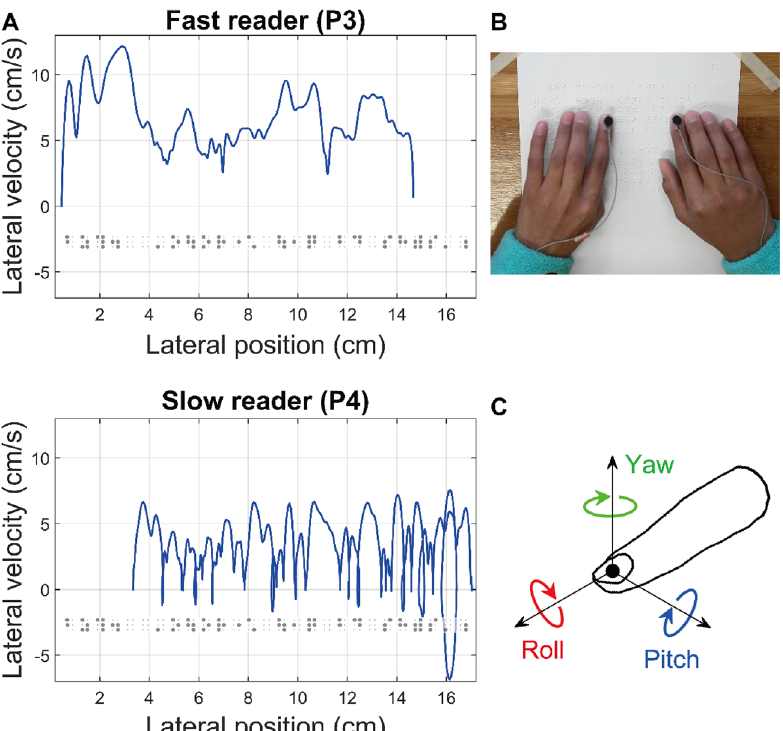
Figure 1. ( A ) Examples of individual lateral velocity traces as a function of the dominant reading finger’s lateral position on a single line of text (shown as rendered in contracted braille) of a fast reader (top, P3) and a slow reader (bottom, P4: In this trial, P4 skipped the first word of the line). ( B ) Experimental set-up. An electromagnetic micro-sensor was attached on the nail of each index finger of the participant reading braille. ( C ) Representation of the three angular displacements in the sensor attached on the nail of the index